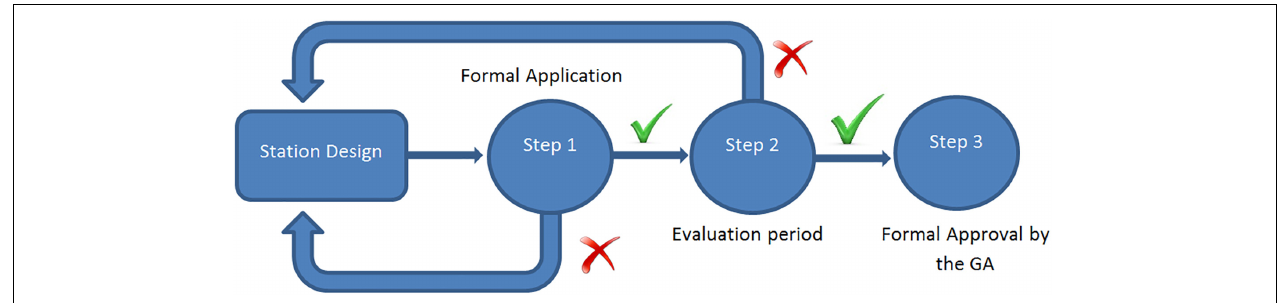
FIGURE 5 | ICOS labeling process. This process is common for all domains. Green ticks indicate that the step is successfully completed, while red crosses indicate that there are issues that need to be addressed before proceeding to the next step.